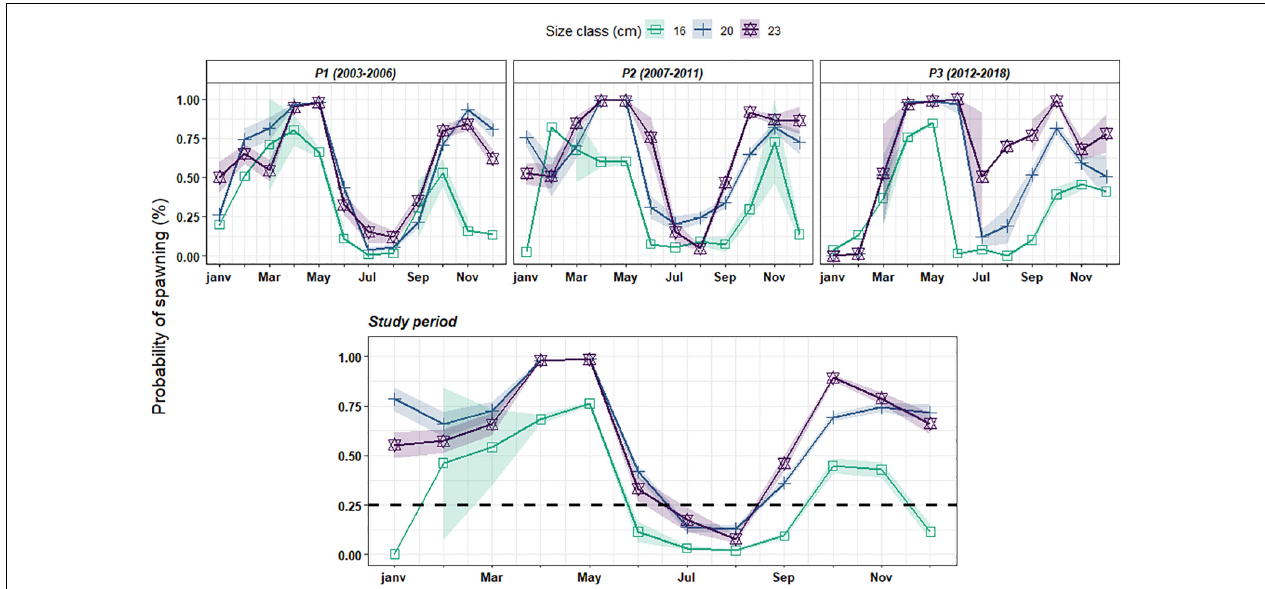
FIGURE 1 | Estimated probability of spawning for three length classes [16 cm (green), 20 cm (blue), and 23 cm (purple)] corresponding to the mean length at ages 1, 3, and 6 over the study period. The first three panels correspond to prediction considering the three identified periods in Véron et al. (2020) (P1: 2003–2006; P2: 2007–2011 and P3: 2012–2018) while the last one represents prediction considering the whole study